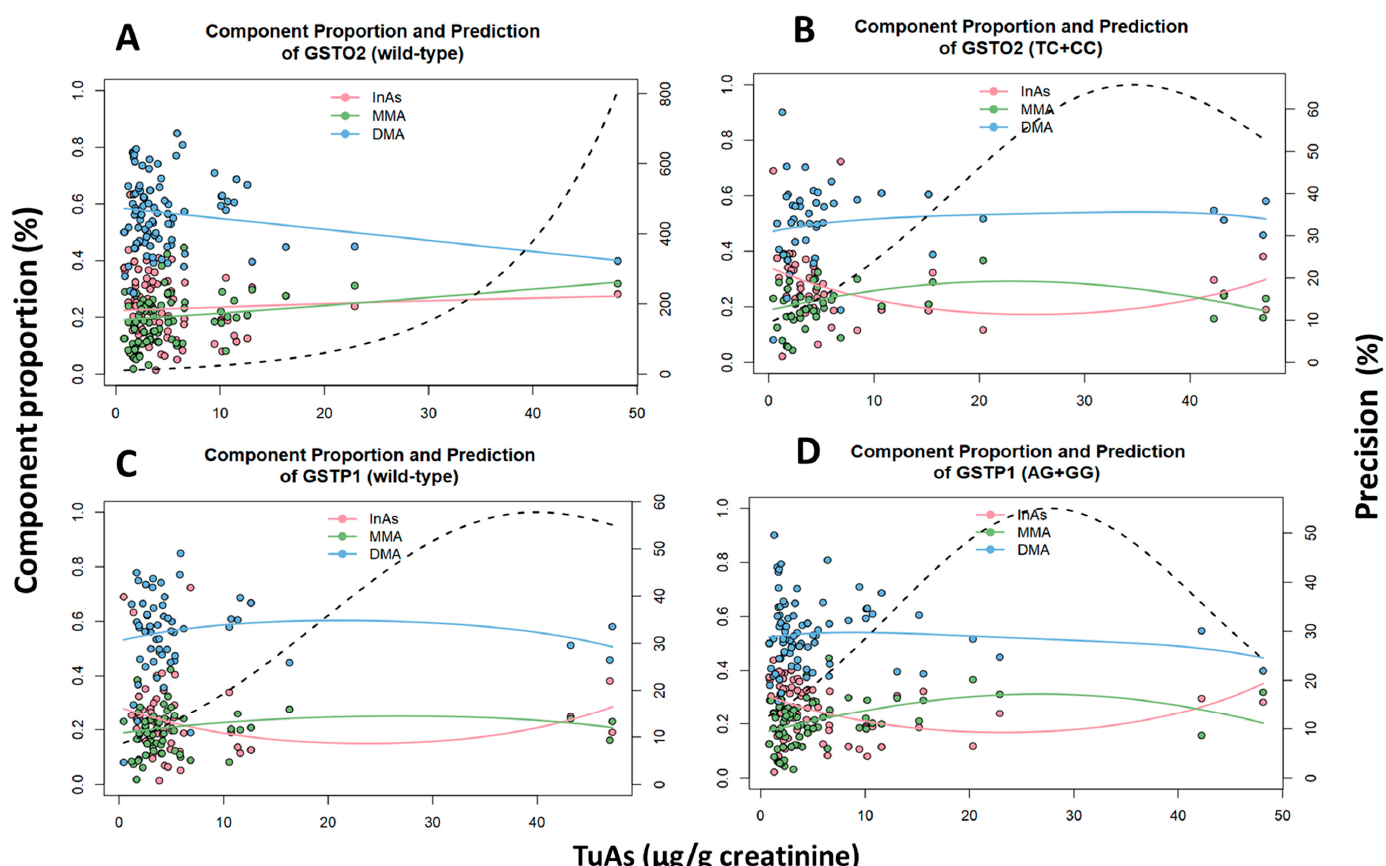
Figure 2. Multivariate Dirichlet regression on the relationship among the urinary arsenic metabolites and total urinary As concentration by genotype adjusted. ( A ) Wild-type genotype of GSTO2 : InAs ( p < 0.01), MMA ( p = 0.01) and DMA ( p < 0.01). ( B ) Heterozygous + homozygous genotypes of GSTO2 : InAs ( p = 0.27), MMA ( p < 0.01) and DMA ( p = 0.01). C. Wild-type genotype of GSTP1 : InAs ( p = 0.51), MMA ( p = 0.02) and DMA ( p = 0.03). D. Heterozygous + homozygous genotypes of GSTP1 : InAs ( p = 0.15), MMA ( p < 0.01) and DMA ( p < 0.01).